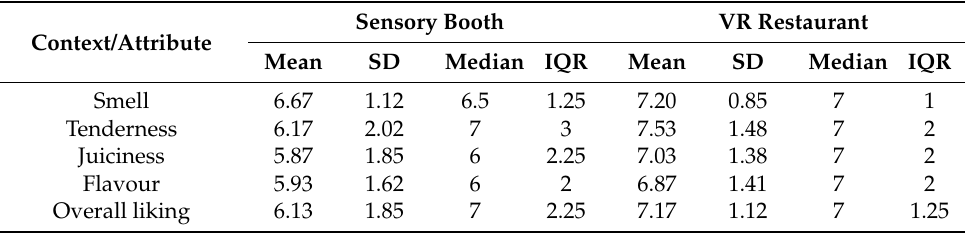
Table 1. Means, standard deviations (SD), medians and interquartile ranges (IQR) for participant he- donic ratings * of beef in a traditional sensory booth and a virtual reality (VR) restaurant environment. Sensory Booth Context/Attribute